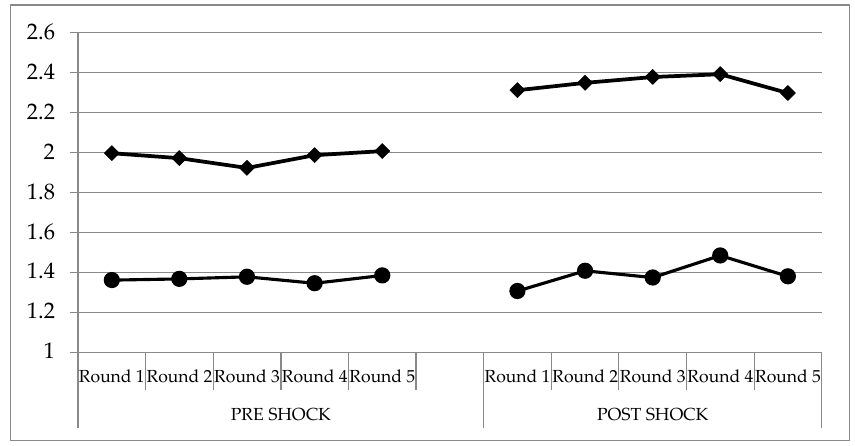
Figure 1. The Effect of Information on Mean Bids by Product and by Round. Note: the y axis is expressed in Euros ( € ).